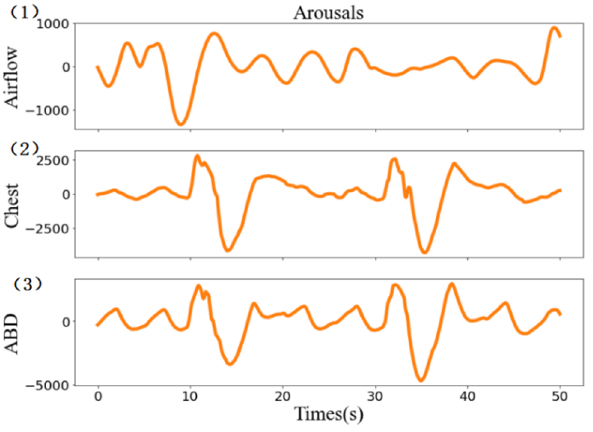
Figure 2. Airflow, chest, and ABD channels during awakening events.